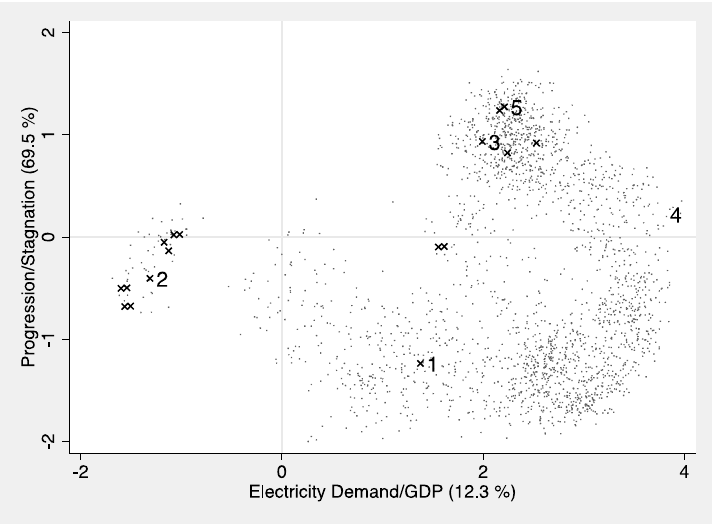
Figure 1. Position of the five selected scenarios among the 2236 consistent scenarios on the MCA-Plot. Fully consistent scenarios are marked by x.